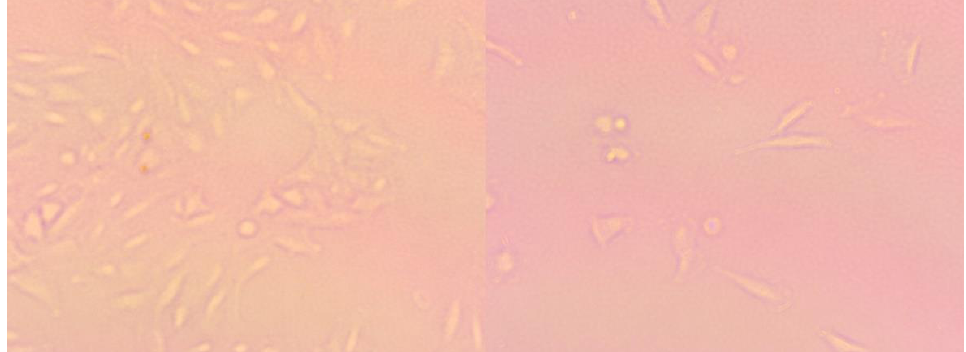
Figure 15. Antitumor effect of Cd(L)Cl 2 compound with silver nanoparticles on A549 cancer cells. Cells were cultured in the presence ( right ) or in the absence ( left ) of tested compounds. Representative phase-contrast cell images are shown after 24 h (100 magnification).